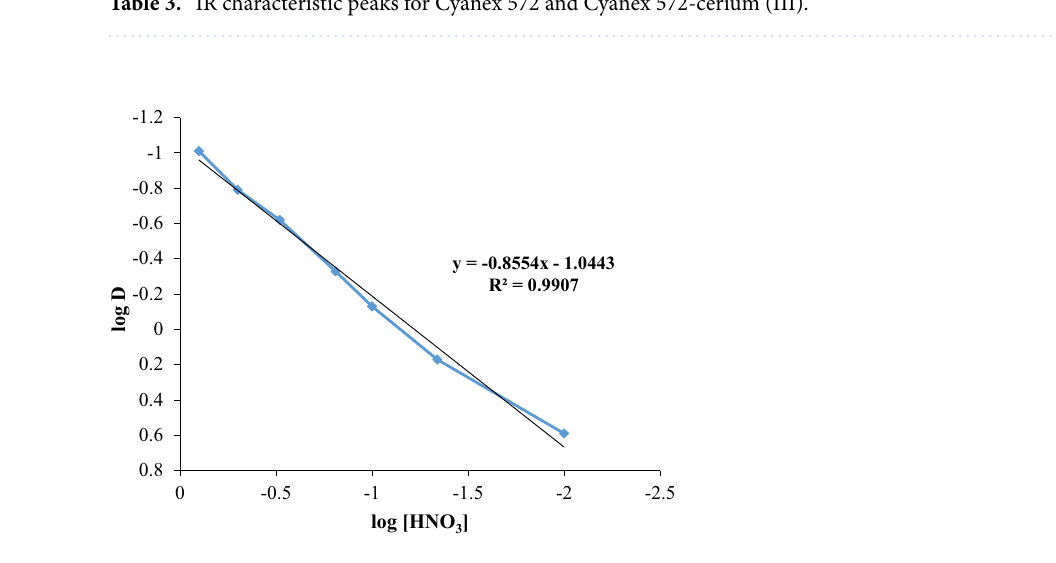
Figure 6. Influence of nitric acid concentration on the distribution coefficient of cerium (contact time = 20 min, [Ce] = 0.04 M, [Cyanex 572] = 0.5 M, and stirring speed = 300